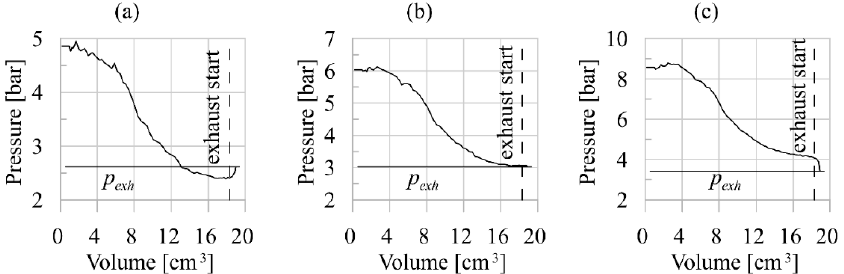
Figure 11. SVRE experimental indicated cycle: ( a ) overexpansion; ( b ) nominal expansion; and ( c ) underexpansion.